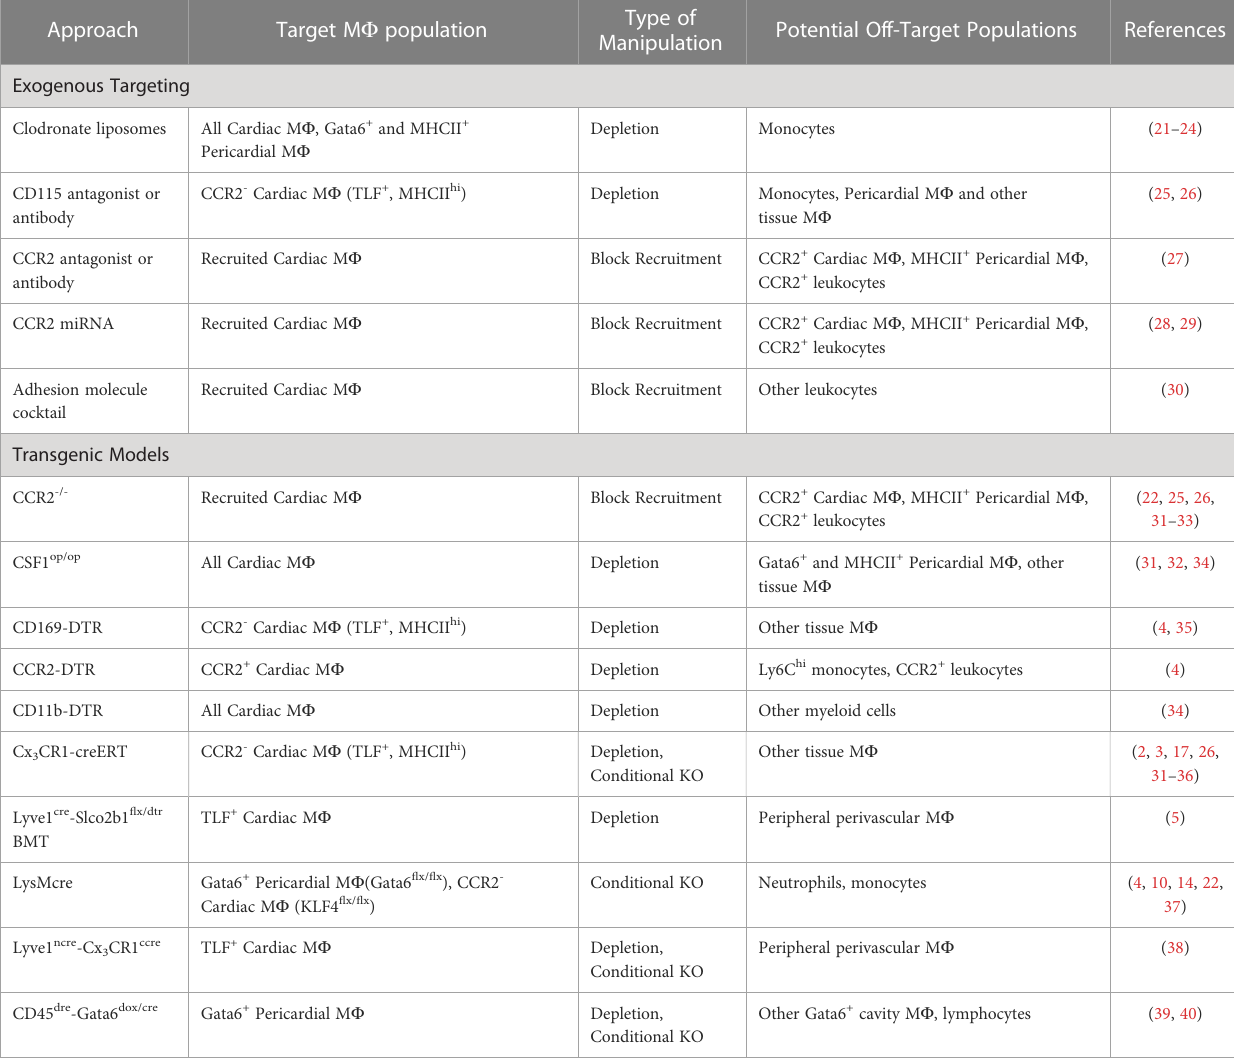
TABLE 1 Exogenous and genetic tools to target cardiac and pericardial macrophages.